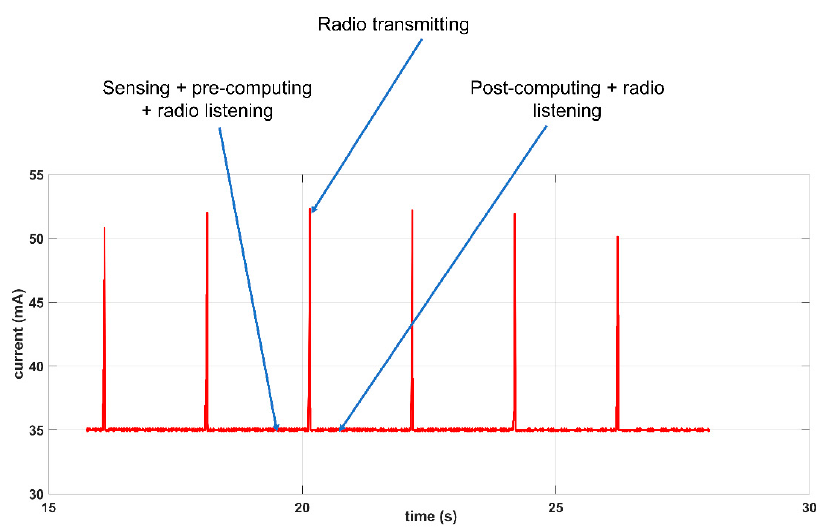
Figure 14. Sensor node’s current profile from physical measurements.